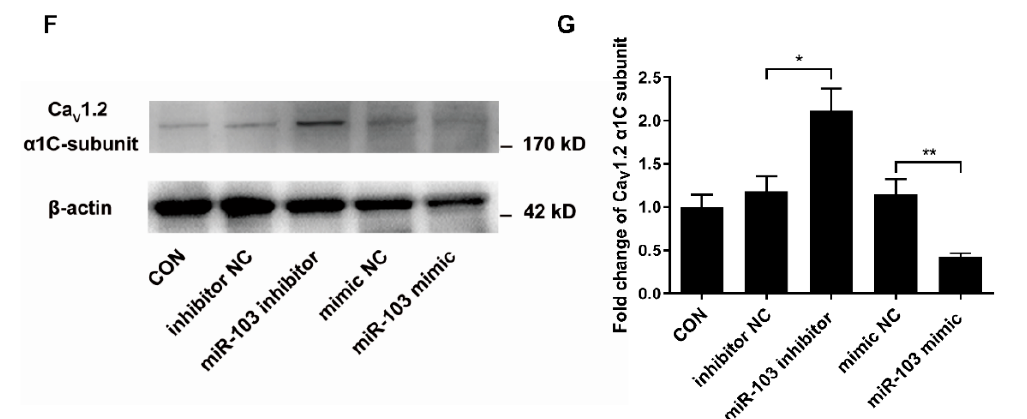
Figure 4. Identification of Ca V 1.2 α 1C-subunit as the down target of miR-103 in VSMCs. ( A ) Computational prediction of Ca 2+ signaling-related miRNAs by evaluating the published literatures and the prediction software programs of miRanDa, miRDB, and Targetscan. ( B ) qRT-PCR was performed to examine the mRNA levels of eight candidate miRNAs in cerebral VSMCs of SUS rats (